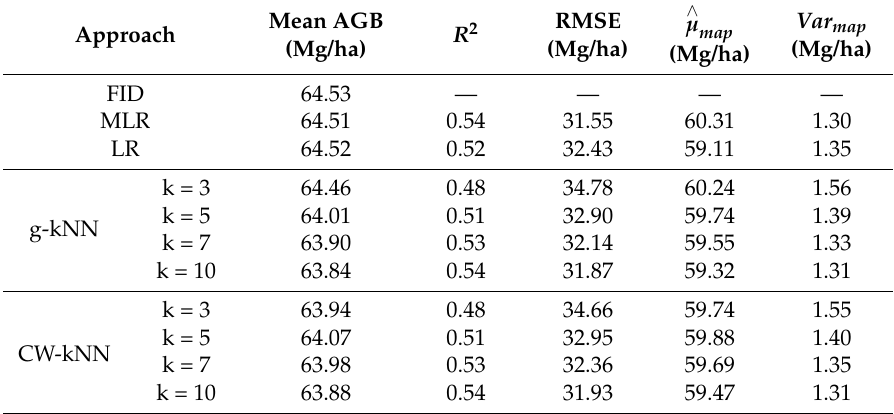
Table 1. The accuracy assessments of forest aboveground biomass density (AGB) estimates from